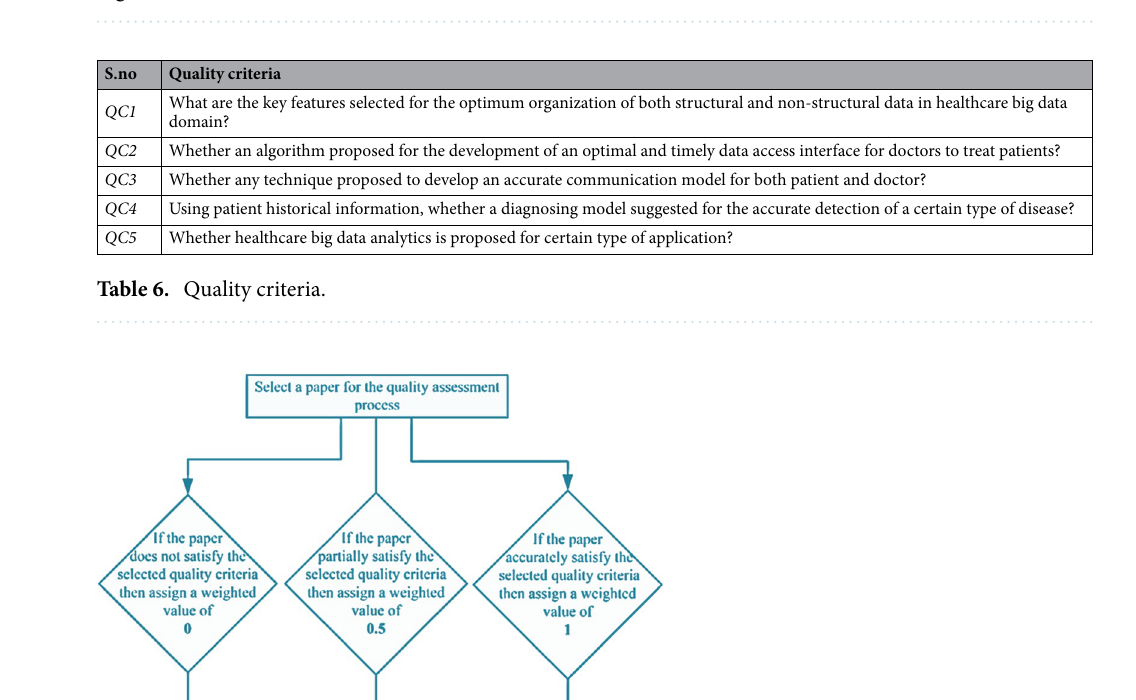
Figure 10. Evolution of final database.